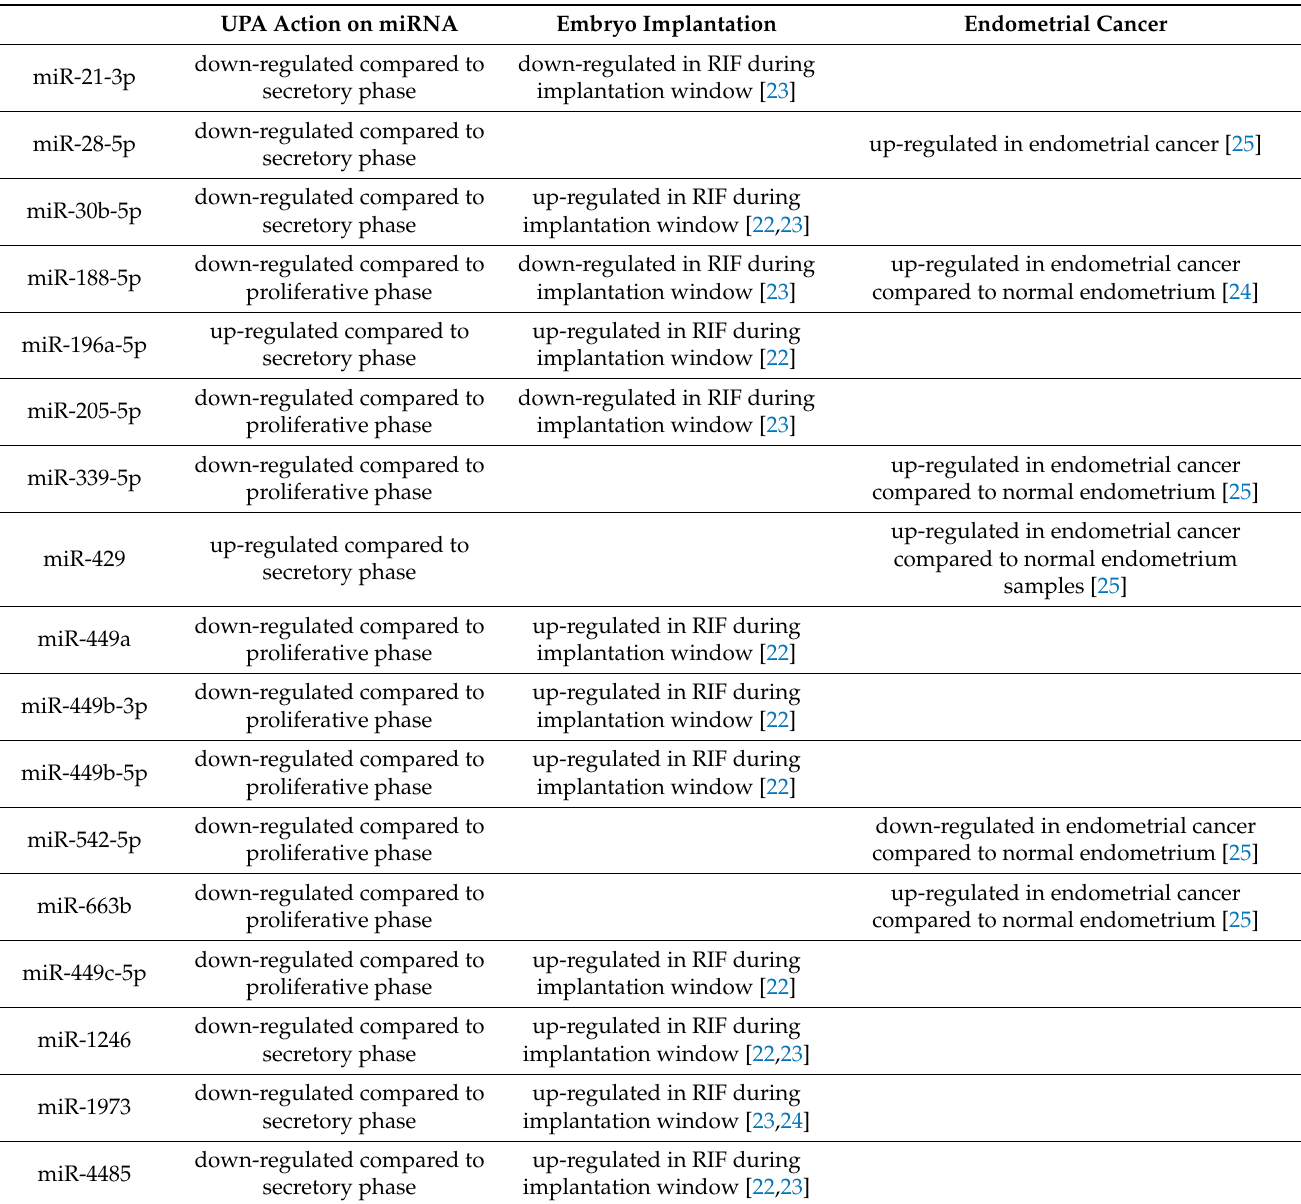
Table 2. Literature data on the involvement of identified miRNAs in embryo implantation and endometrial cancer. UPA Action on